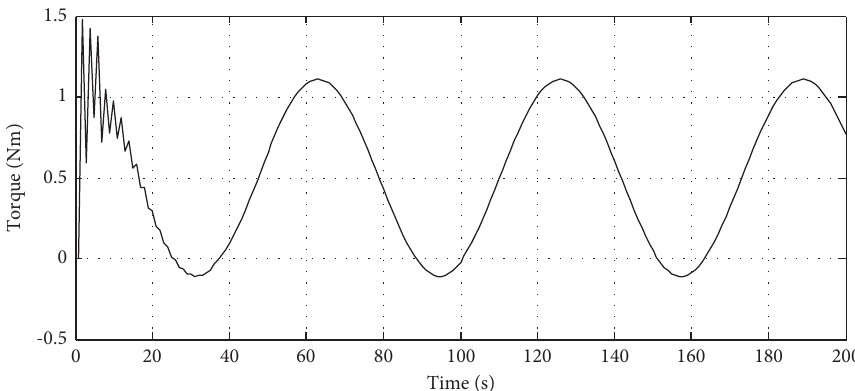
Figure 12: PMSM torque when the parameters are halved.